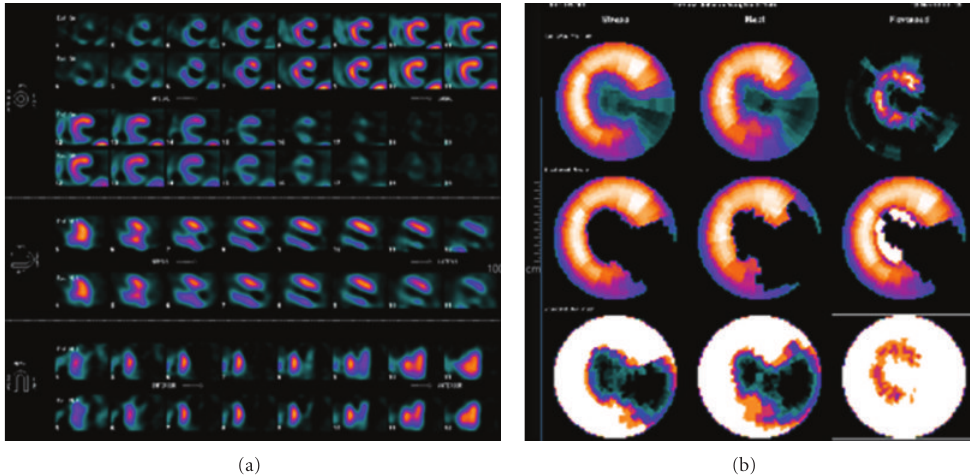
Figure 4: (a) The myocardial perfusion imaging with TC-99M Sestamibi SPECT at rest and stress with dipyridamole demonstrated left ventricular lateral wall and apical transmural myocardial infarction without peri-infarction myocardial ischemia. (b) Bull’s eye plots were created by automated quantitative analysis software, representing the stress and rest data.